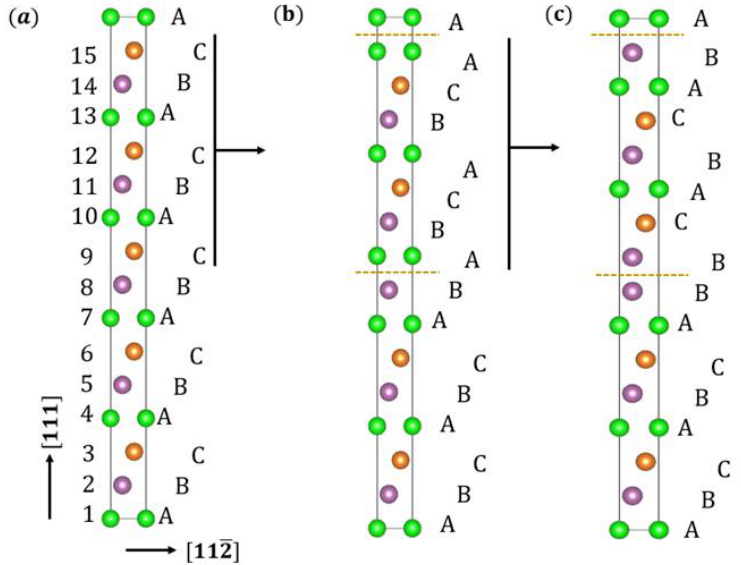
Figure 1. Selective schematic supercells to show the formation of two generalized stacking faults (i.e., the brown dash-dot lines) produced in the anti-alias of fcc crystal during the slip processes: ( a ) perfect structure; ( b , c ) stacking fault structure. The letters A, B and C represent the different layers of fcc crystals respectively, where green, purple and brown circles indicate atoms in layer A, B and C, respectively.